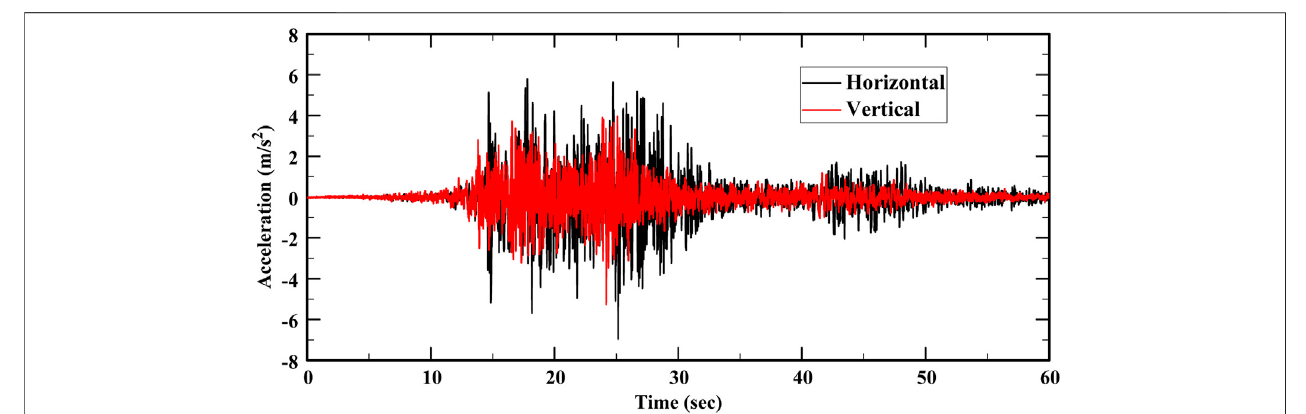
FIGURE 8 | Input horizontal and vertical ground acceleration records after fi ltering and baseline